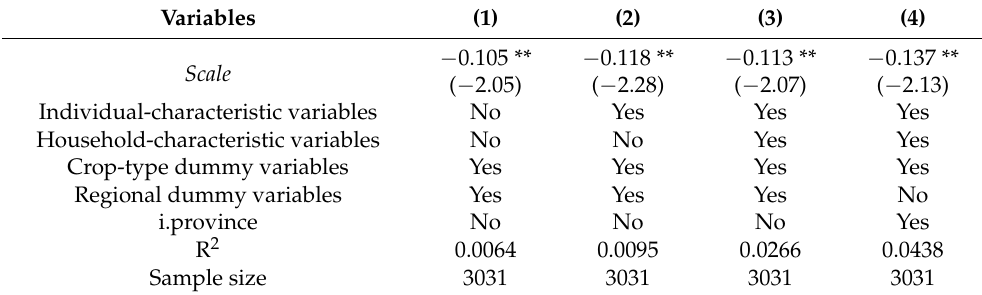
Table 3. Influence of the scale of cultivated land management on fertilizer-application amount per hectare (main grain-producing